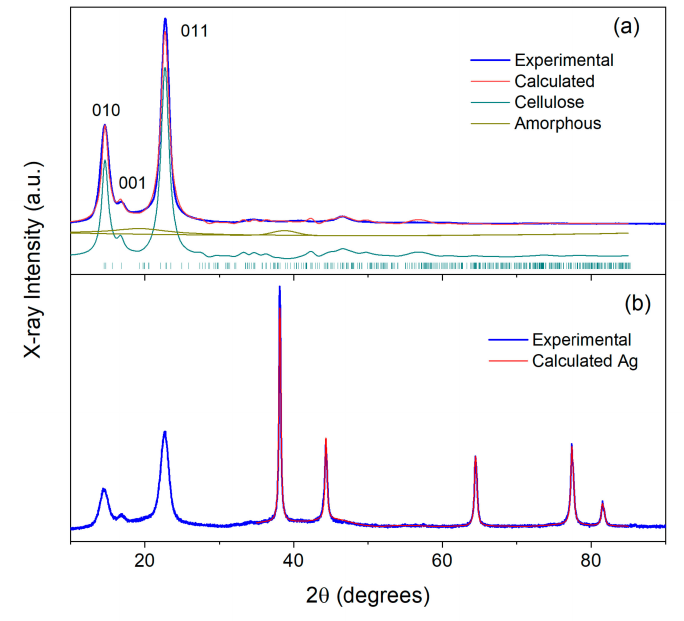
Figure 11. ( a ) X-ray diffraction pattern of initial BCF ( a ) and composite Ag NPs/BCF ( b ) and their fits. The main cellulose reflections and reflections of Ag metal are designated by